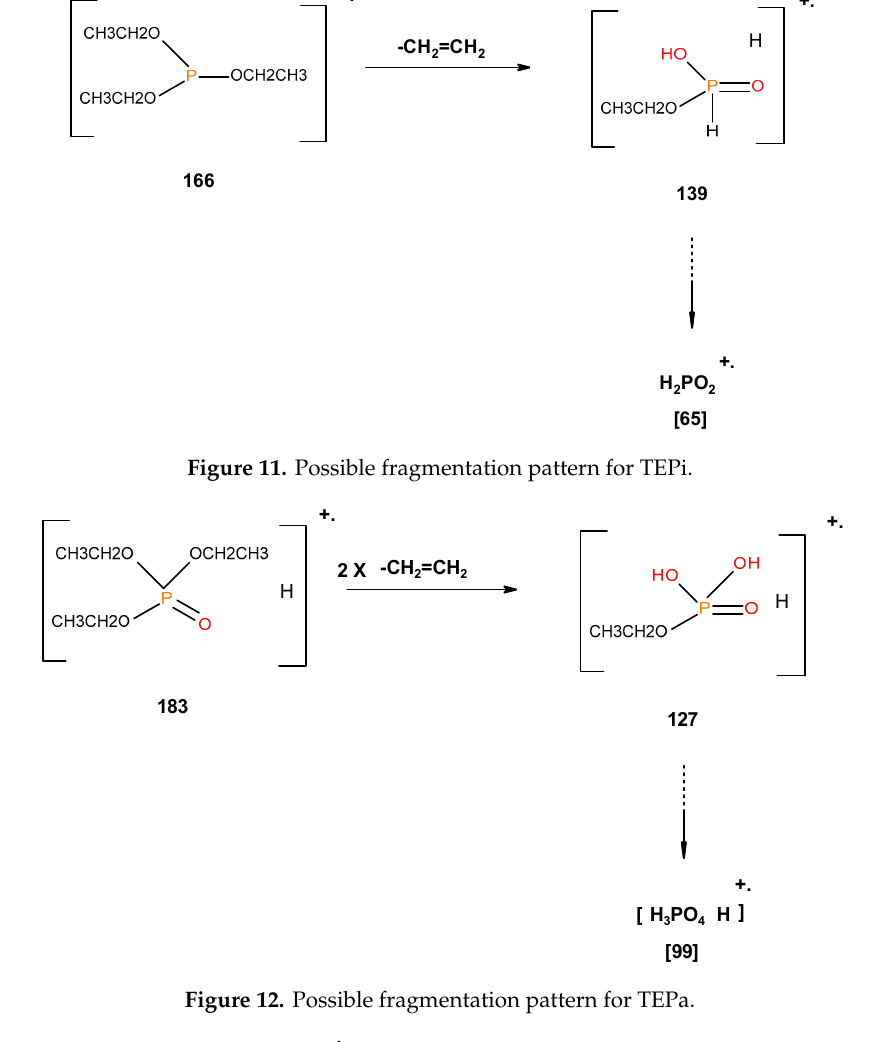
Figure 12. Possible fragmentation pattern for TEPa.